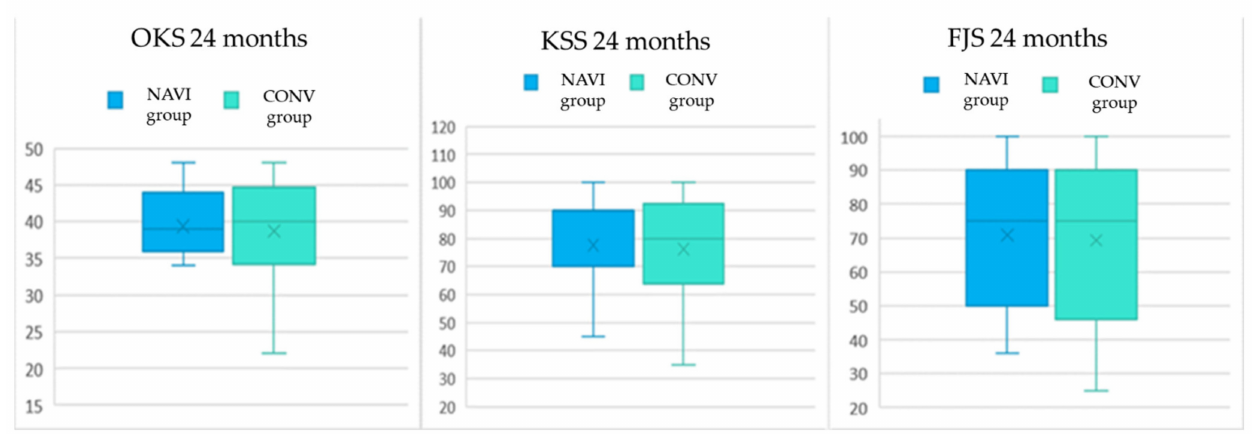
Figure 1. Box Plot of postoperative 24 m clinical